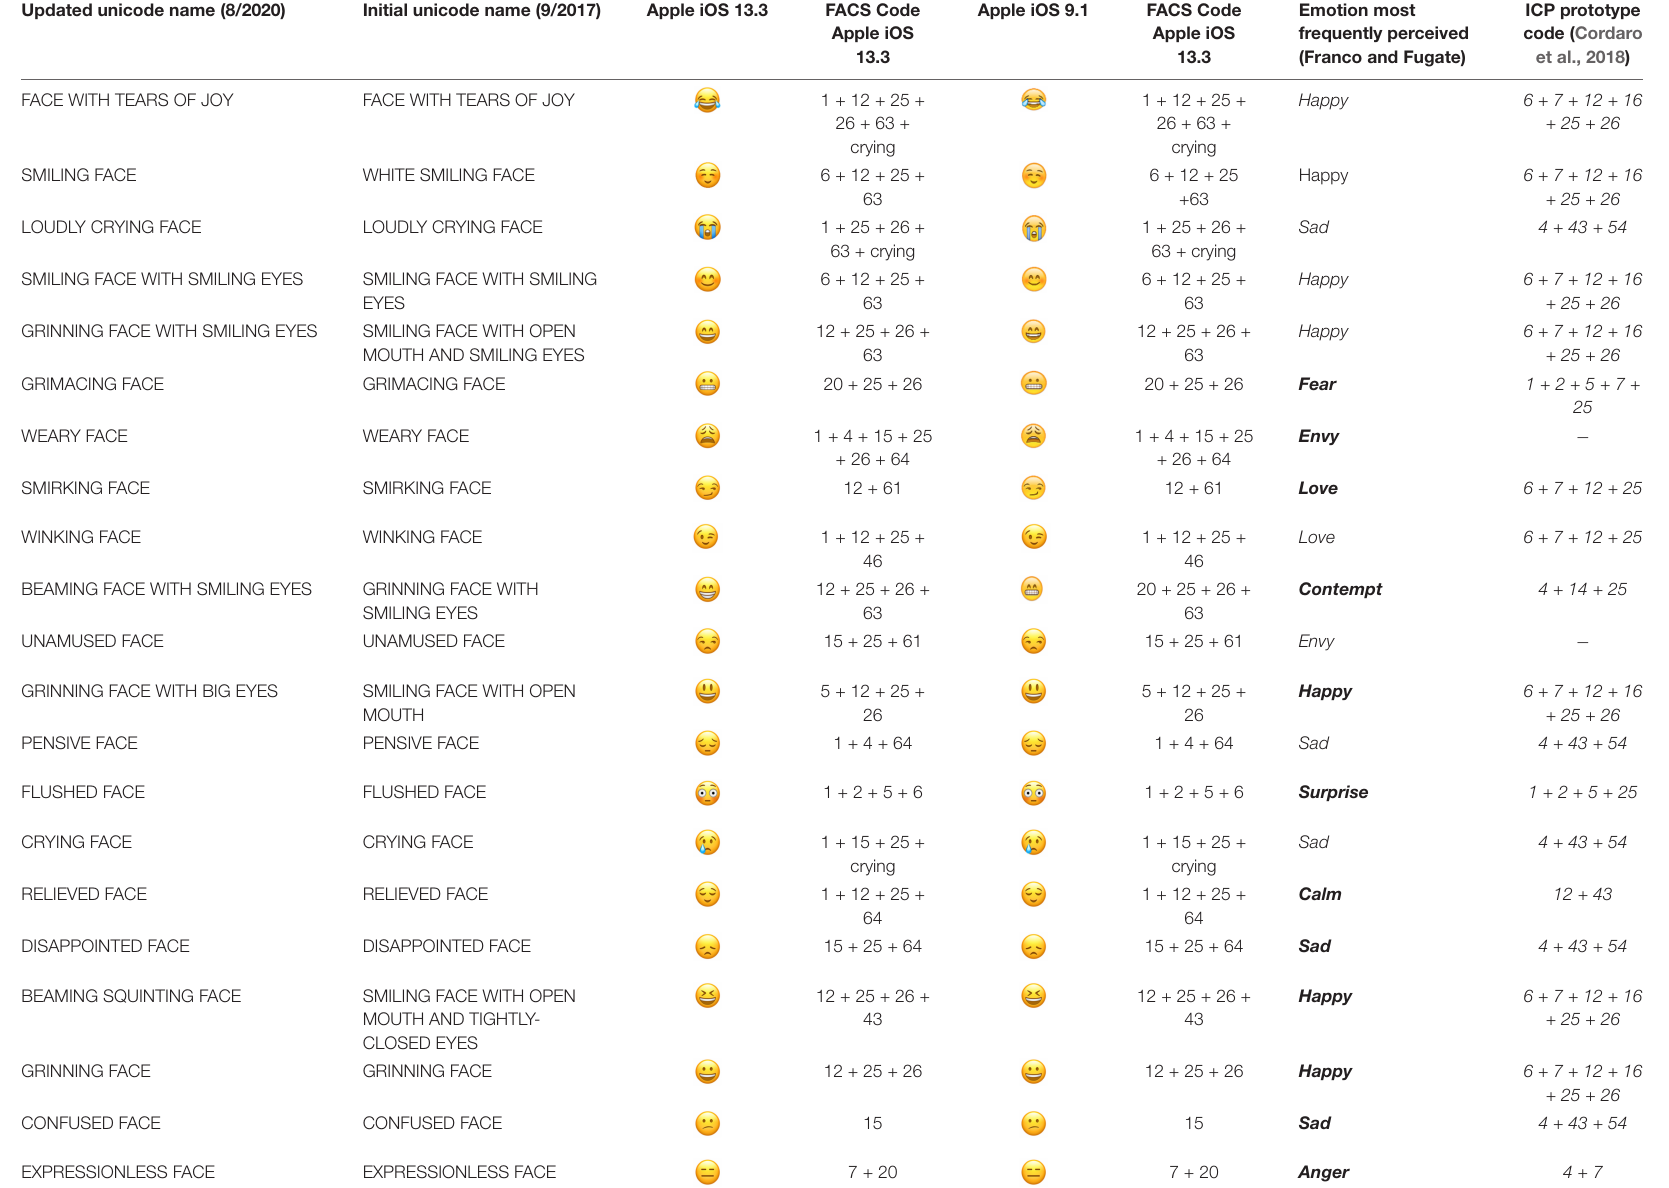
TABLE 2 | Emojis for both Apple Platform Versions with FACS Code and Perceived Emotion (Additional Platforms